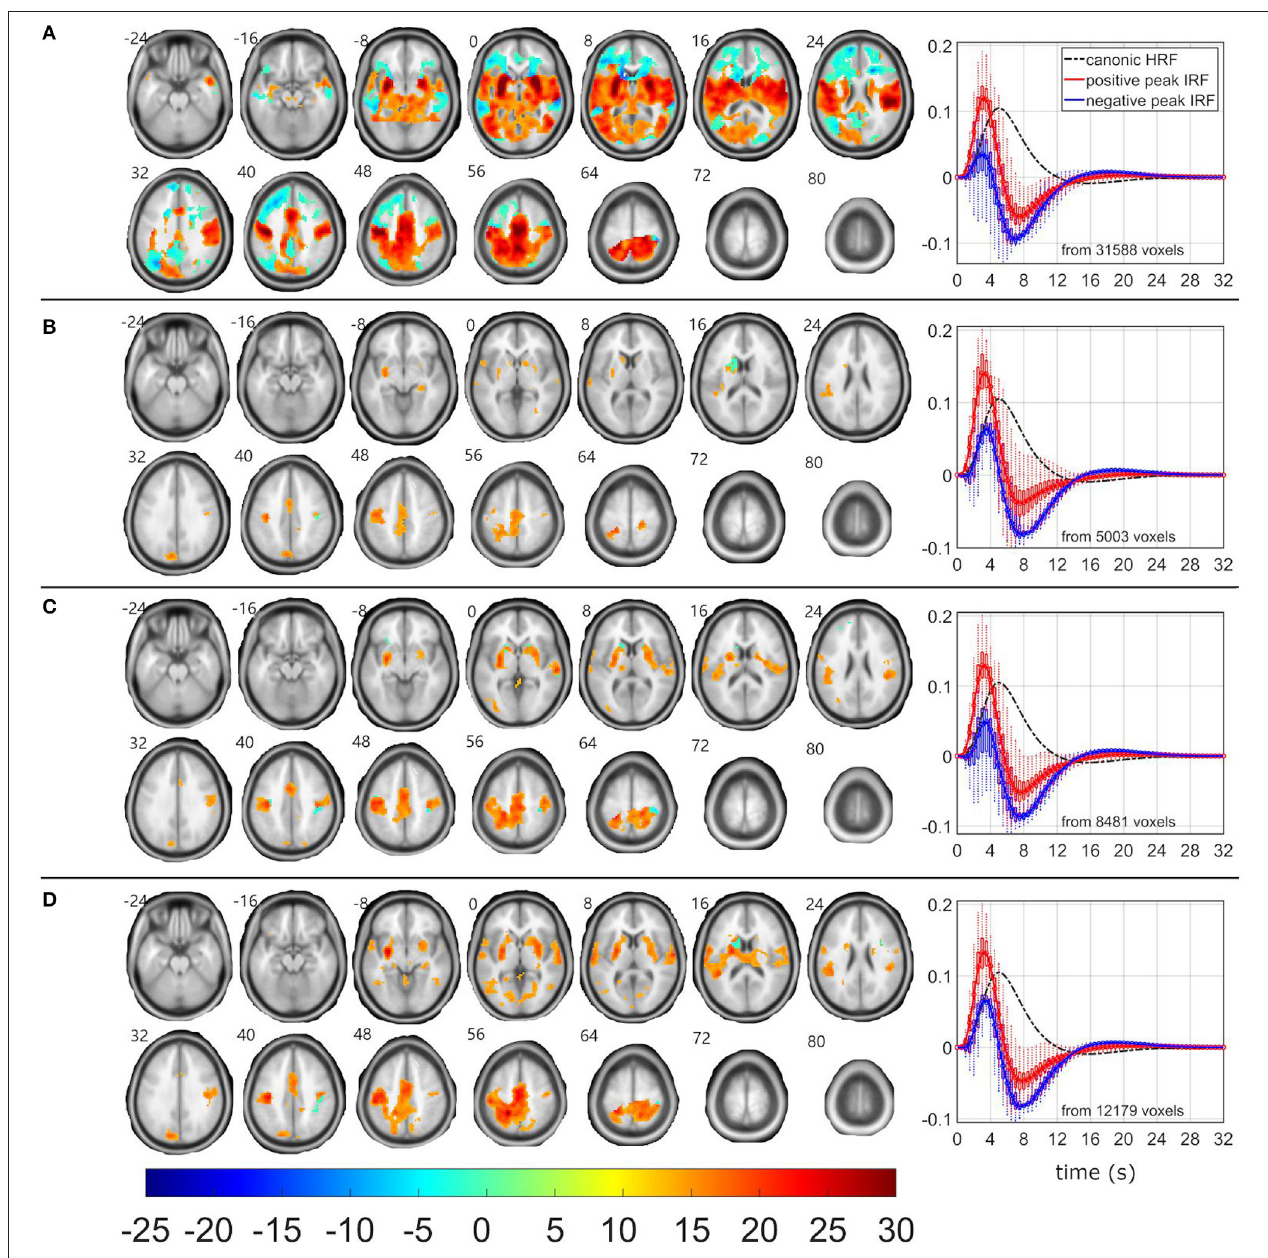
FIGURE 4 | EEG-fMRI F-maps and estimated hemodynamic response functions for all investigated models of the θ 1 pattern. The EEG-fMRI F-map colorbar is the same over all models. HRF, hemodynamic response function; IRF, impulse response function. If HRF demonstrated a reduced peak and an amplified trough (i.e., blue color-coded HRFs) the F -values were assigned with a negative sign. The F-maps were thresholded with p < 0.0001, i.e., |F| > 8.1. The voxels with |F| > 12.1 met the condition p FWE < 0.05. The red color coded HRFs were derived from voxels with positive signed suprathreshold F -values. All F-maps are shown following the neurological convention, i.e., left hemisphere on the left side of the axial slice. (A) Absolute spectral. (B) Relative spectral. (C) Absolute spatiospectral. (D) Relative